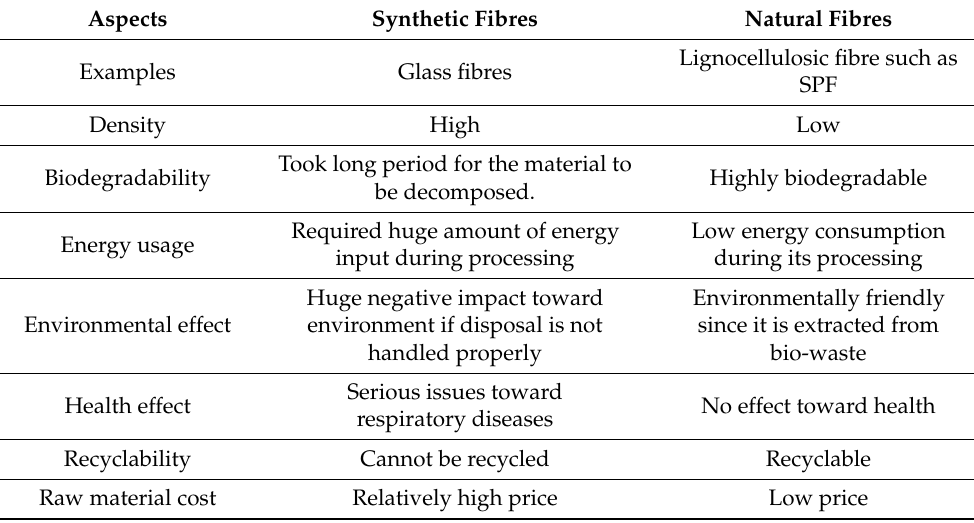
Table 1. Comparison of natural fibres with synthetic fibres